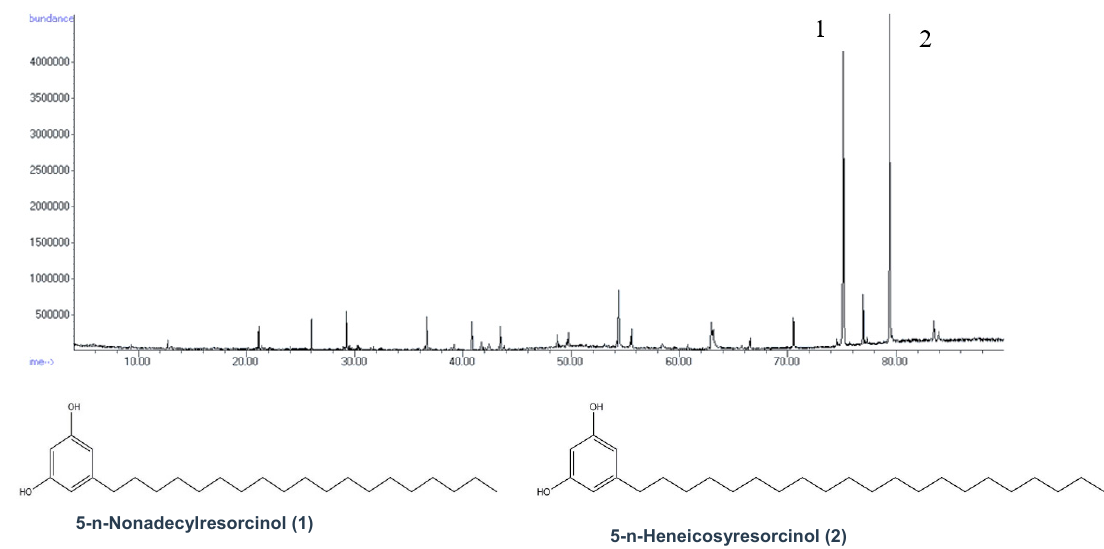
Figure 3. GC chromatogram of the isolated compounds.